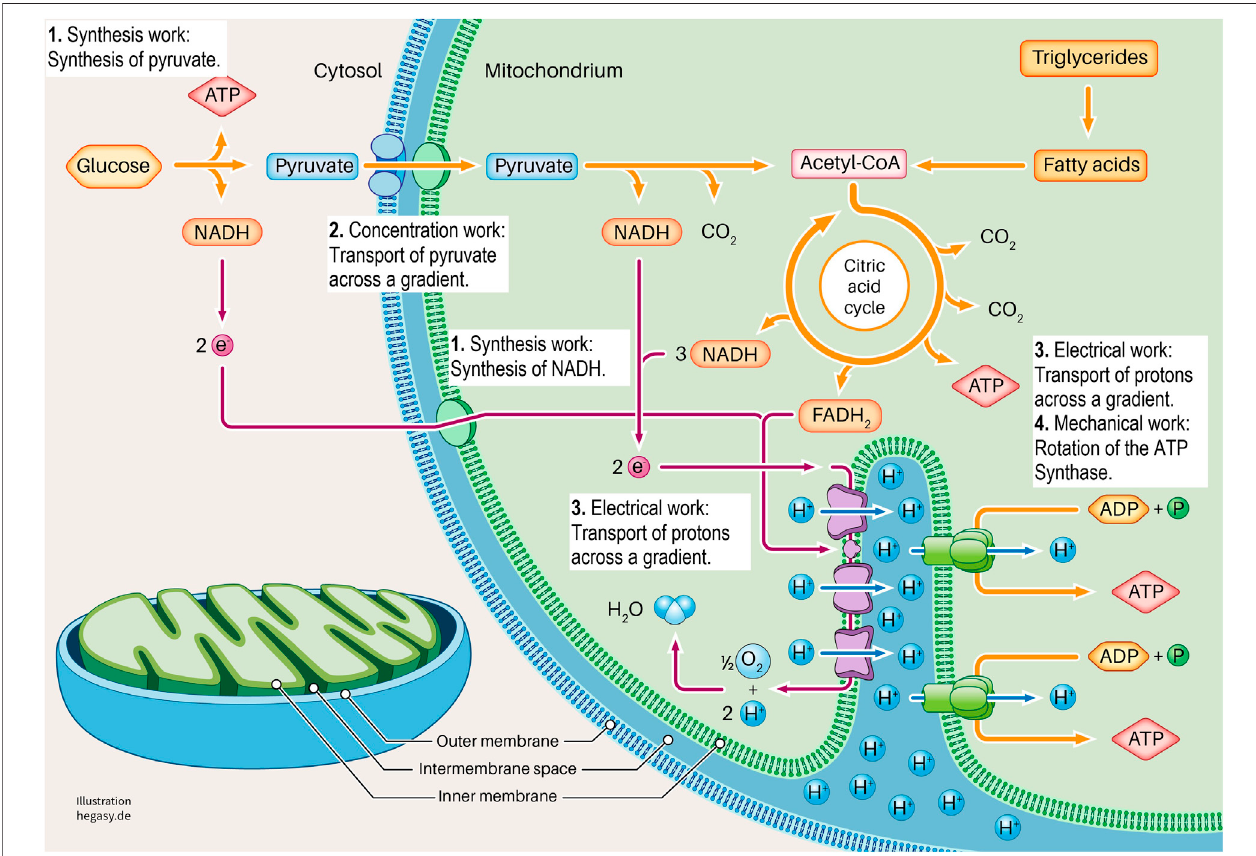
FIGURE 3 | Here we show the section of a cell in which glycolysis and cell respiration are shown in a simpli fi ed form. It is clear here that this system requires four forms of cell work to generate ATP (1-4). These are synthesis work (1), concentration work (2), electrical work (3), and mechanical work (4). See the text for further explanations. To describe the individual work processes and their interrelationships in more detail, it is not suf fi cient to look at the individual proteins. For this purpose, further important parameters must be considered. These are the existing energy, the existing milieu, and the mechanics that in fl uence different levels. In this way, the cell working process can be adequately characterized and